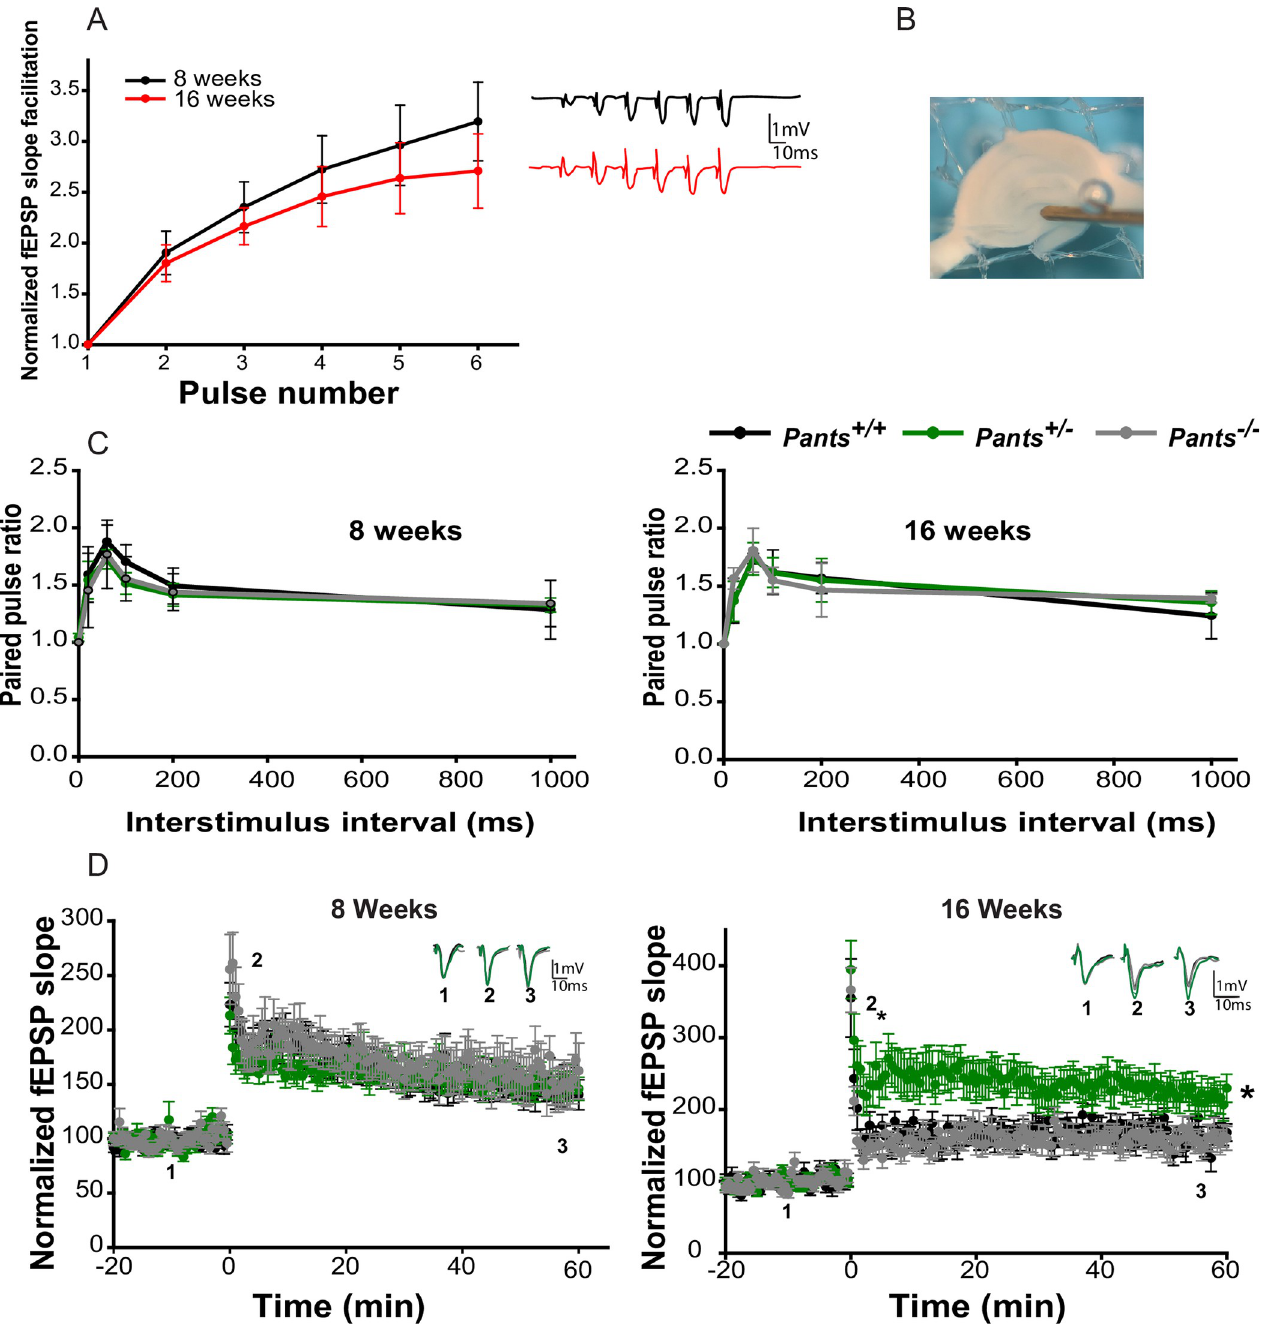
Fig 4. Pants exerts an age-dependent, overdominant, negative effect on hippocampal Mossy Fiber LTP. A) Frequency Facilitation at mossy fibers from acute hippocampal slices at 8 and 16 weeks of age (n = 5). B) electrode placement for mossy fiber LTP measurement. C ) Paired-pulse facilitation at MF synapses at 8 and 16 weeks of age (n = 5). D ) 100 Hz LTP recorded at MF synapses from 8 week old (left), and 16 week old (right) Pants +/+ (black), Pants +/- (dark green), and Pants -/- (light green) acute hippocampal slices. 8 week (n = 6 mice, 18 slices for Pants +/+ , n = 10 mice, 30 slices for Pants +/- , and n = 5 mice, 15 slices for Pants -/- . All P > 0.503). 16 week (n = 4 mice, 18 slices for Pants +/+ , n = 5 mice, 18 slices for Pants +/- , n = 5 mice, 19 slices for Pants -/- . P < 0.001 for Pants +/+ vs. Pants +/- . P = 0.157 for Pants +/+ vs. Pants -/- . P < 0.001 for Pants +/- vs. Pants -/- , Mann-Whitney).